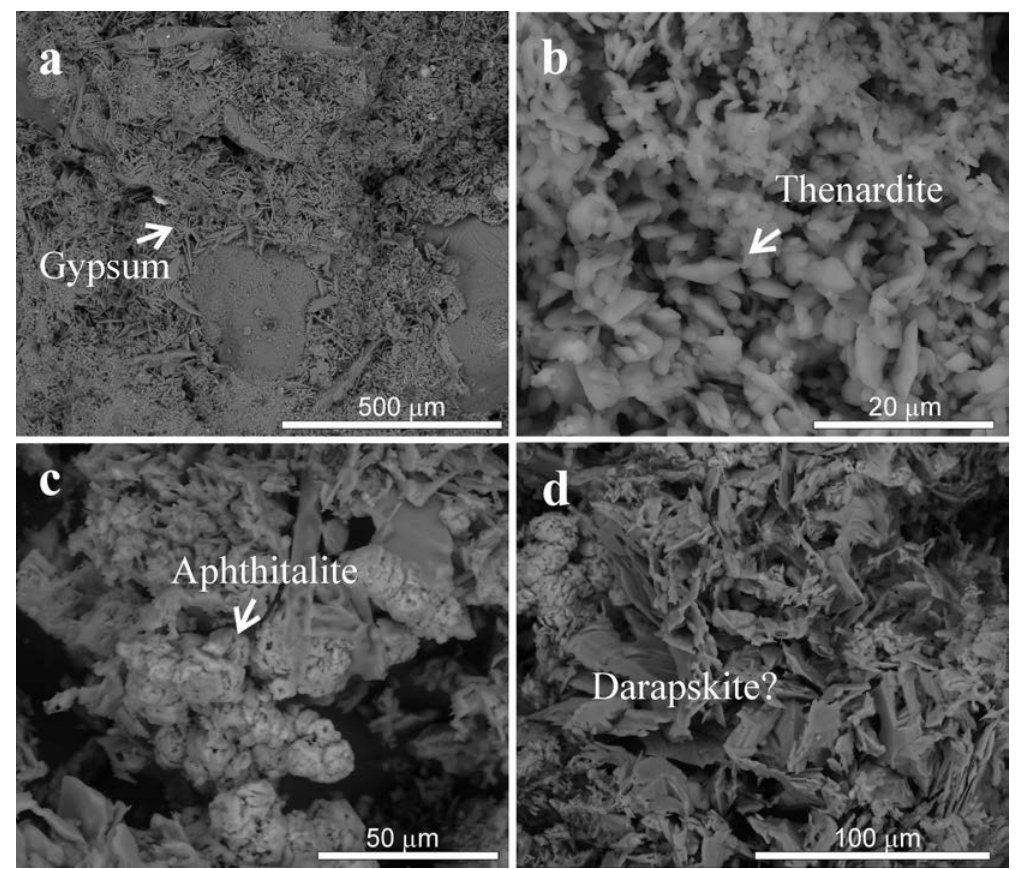
Figure 11. Backscattered (BSE) electron image of the secondary salts from the crust of the sample KD-M-3 ( a ) and from the efflorescence at the border between the subwall limestone blocks and cement mortar ( b–d ).